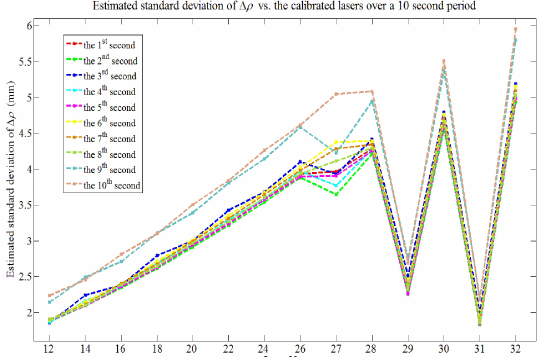
Figure 10. The standard deviations of the estimated Δ ρ by the calibration for Dataset 1 over a 10 second period